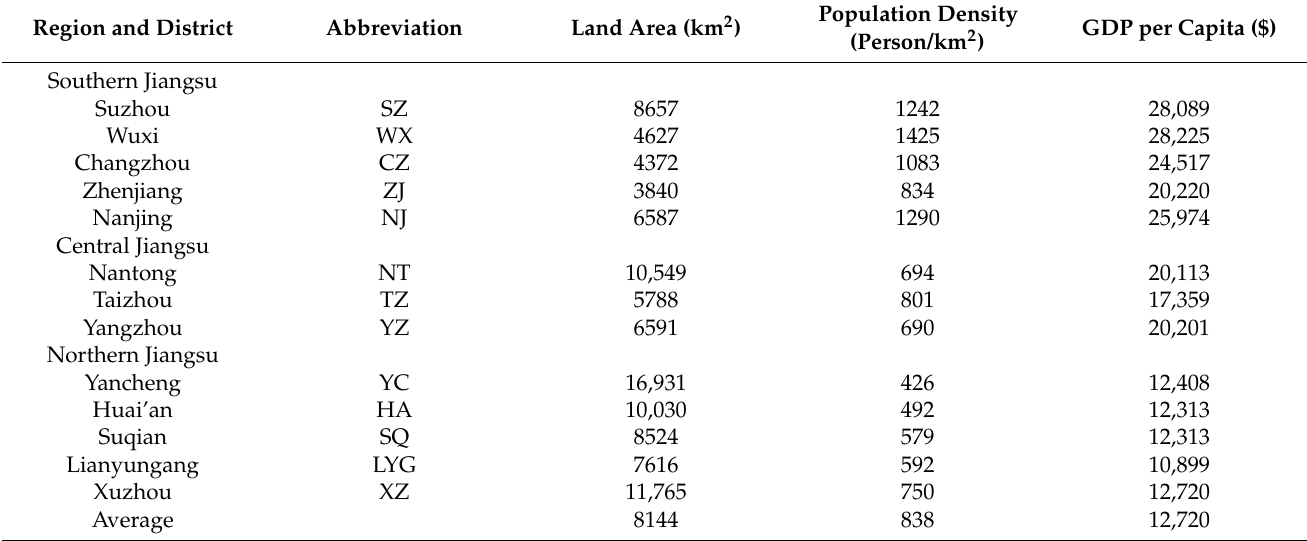
Table 1. Land area, population density, and GDP per capita of 13 cities in Jiangsu Province, eastern China. Region and District